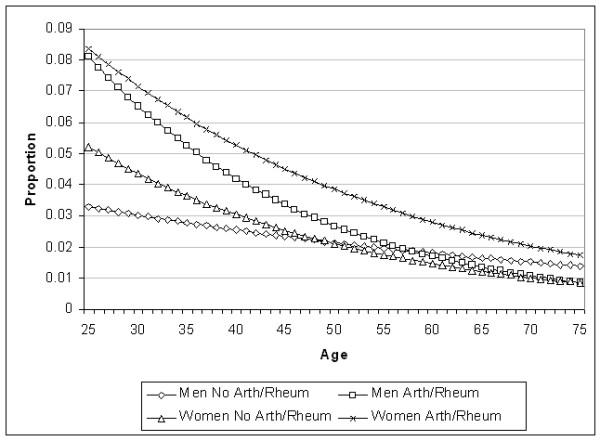
Fitted proportions: logistic regression model for social phobia. The logistic equation is: -2.93 + 1.67 (Arth/Rheum) - 0.018 (Age) + 0.97 (Sex) - 0.029 (Arth/Rheum by Age) - (Age by Sex) - 1.28 (Arth/Rheum by Sex) + 0.033 (Arth/Rheum by Age by Sex). Fitted proportions: odds/1 + odds